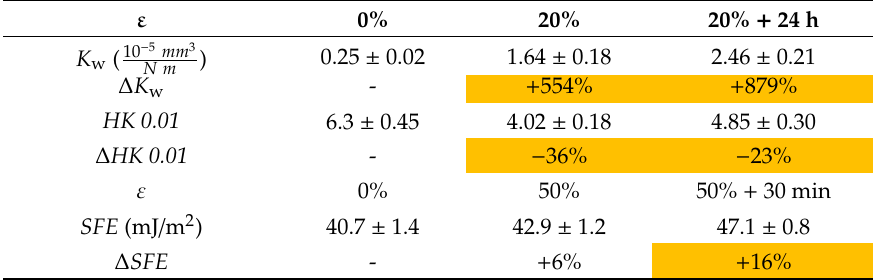
Table 8. Summary of test results on wear ( K w ), surface free energy ( SFE), and microhardness ( HK 0.01 ) for PE-HD maintained in deformation for a